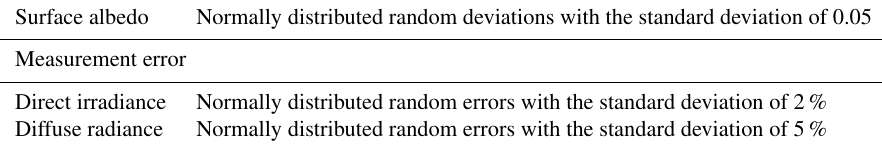
Table 2. Random errors of the simulation in the assessment of retrieval